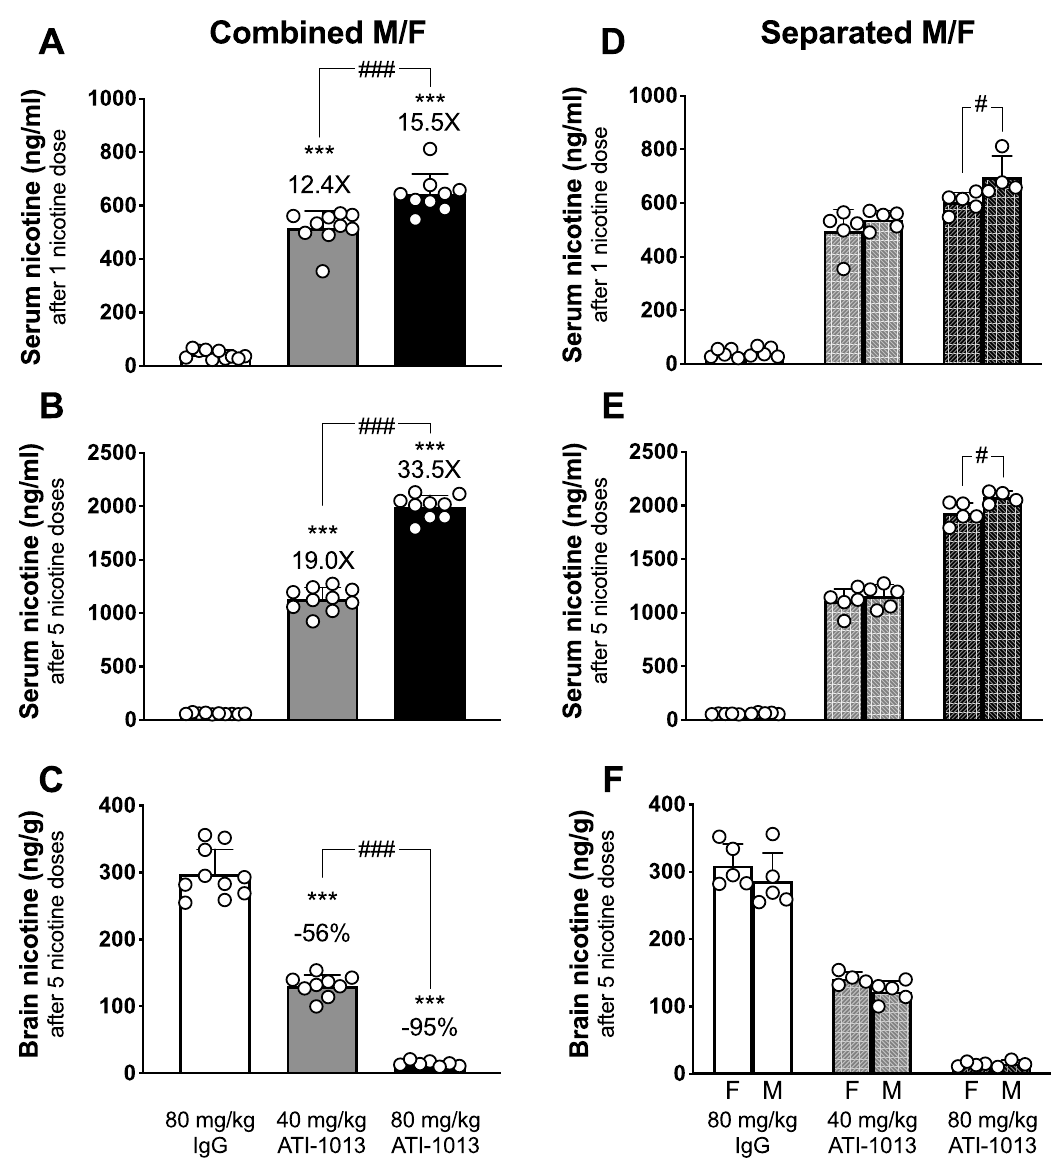
Fig 5. ATI-1013 alters nicotine distribution to serum and brain following repeated administration of nicotine. Two groups of rats (n = 10/group) received ATI-1013 40 or 80 mg/kg i.v. via jugular catheter and one group received 80 mg/kg of non-specific IgG as a control. Twenty-four hours later, 0.03 mg/kg nicotine was dosed i.v. once every 10 min via jugular catheter for a total of 5 doses. Blood was sampled 3 min after the first dose of nicotine (Panels A & D). Animals were sacrificed 3 min after the fifth nicotine dose, i.e., 43 min after the first nicotine dose and blood and brain collected (Panels B, C, E & F). Panels D, E &F show a comparison of results grouped by gender (M, male; F, female). ��� p < 0.001 significantly different compared to controls. # p < 0.05 and ### p < 0.001 significantly different compared to designated group. Data are expressed as Mean ±